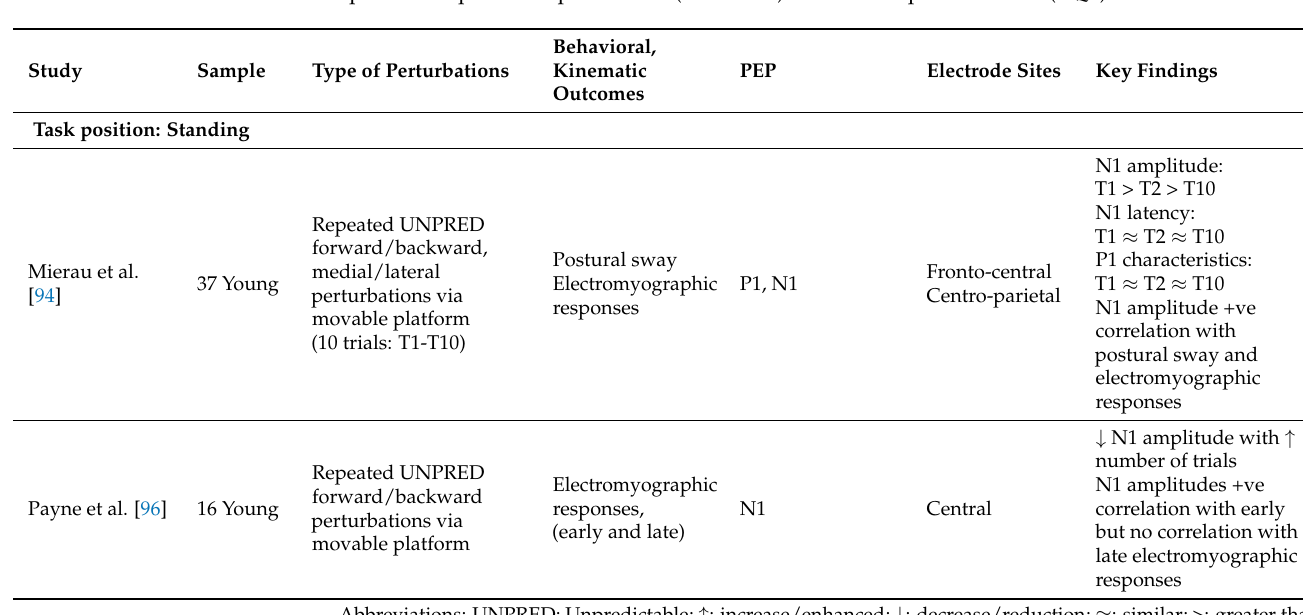
Table 5. Perturbation-evoked potentials (PEPs) recorded via electroencephalography (EEG) in re- sponse to repeated unpredictable (UNPRED) mechanical perturbations